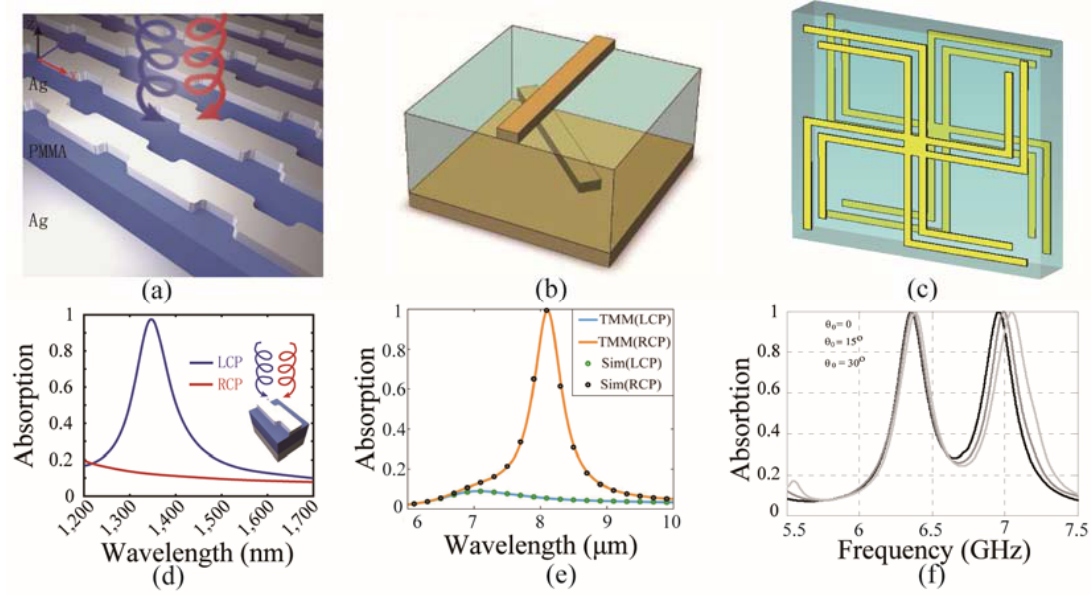
Figure 5. Chiral metamaterials for absorption. ( a ) Schematic structure of planar chiral metamaterial for selective circular polarization absorption; ( b ) Unit cell of chiral metamaterial with two layers of twisted metallic rods; ( c ) Scheme of chiral unit with dual band absorption; ( d ) Circular polarization absorption spectra of the chiral metamaterial in ( a ); ( e ) Numerical results of circular polarization absorption spectra (solid lines calculated by transfer matrix method (TMM) and dot lines calculated